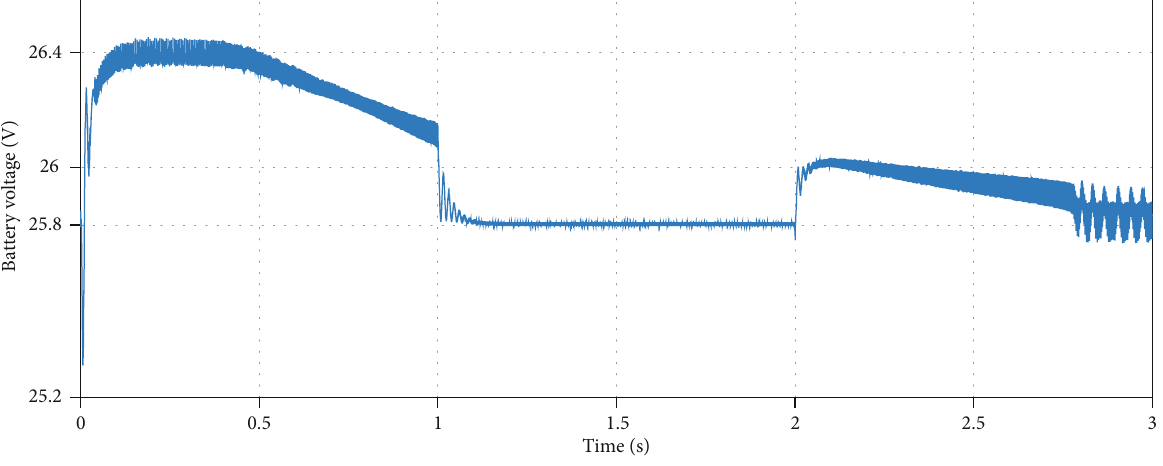
Figure 13: Battery